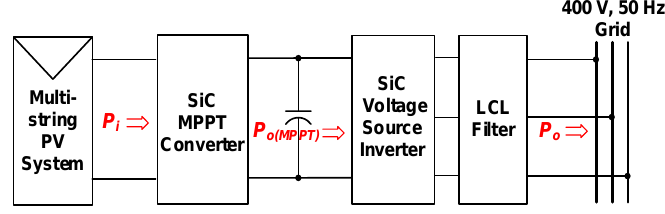
Figure 29. Definition of power components for efficiency calculations. P i is calculated from the measured v pv ( av ) and i pv ( av ) data. P o ( MPPT ) is calculated from the measured v dc ( av ) and i dc ( av ) data. Measuring instruments are Tektronix MSO3034 oscilloscope together with its moving average filters, Tektronix P5205A high voltage differential probe, Tektronix TCP404XL current probe, Tektronix TCPA300 current probe amplifier, and Fluke 80i-110s current probe for i dc . P o is measured by Hioki Power Analyzer PW3198. Instantaneous values v pv , i pv , v dc and i dc are as defined in Figure 3 before averaging for steady-state operation.